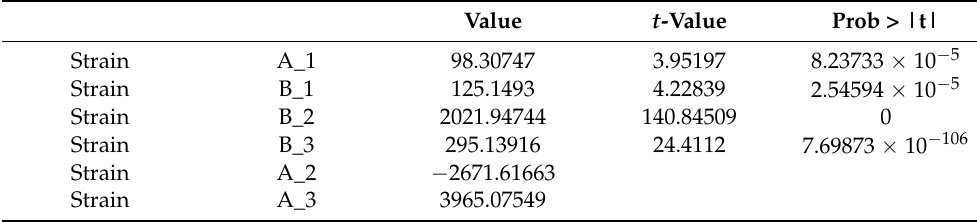
Table 2. Test parameters for significance of fitting curve (red curve) of Figure 11b.